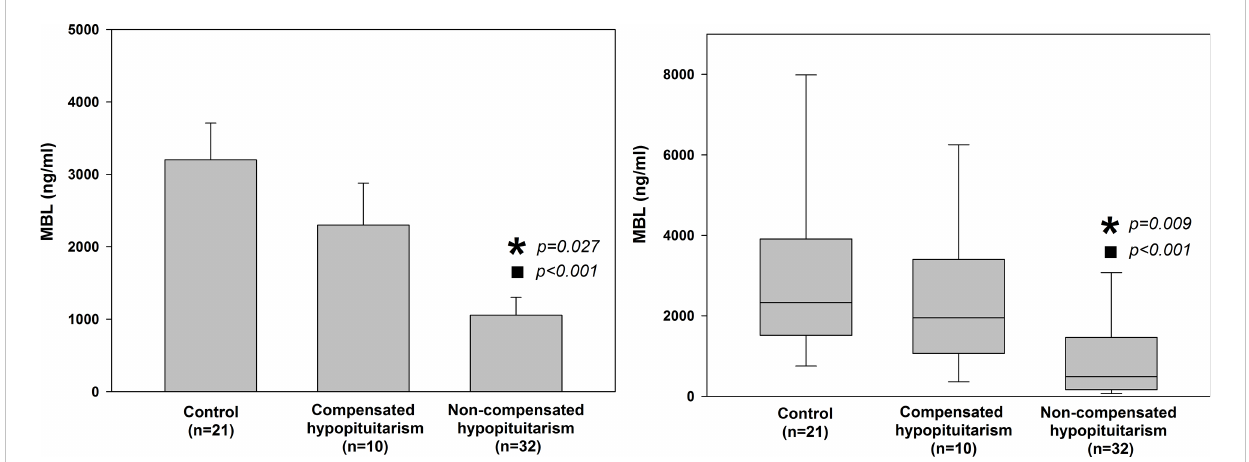
FIGURE 4 Bar chart of mean (± SEM) (left graph) and box plot of median (± SEM) (right graph) values of mannan-binding lectin (MBL) level in control individuals (n=21) and patients with hypopituitarism (n=42) who are on appropriate replacement therapies (compensated hypopituitarism, n=10) vs. inadequate replacement therapies (non-compensated hypopituitarism, n=32). Central line of each box denotes the median, the top and bottom edges of the box show the 25% and 75% percentile, with the 10% and 90% percentiles shown by the upper and lower whiskers. Statistical evaluation was performed by an